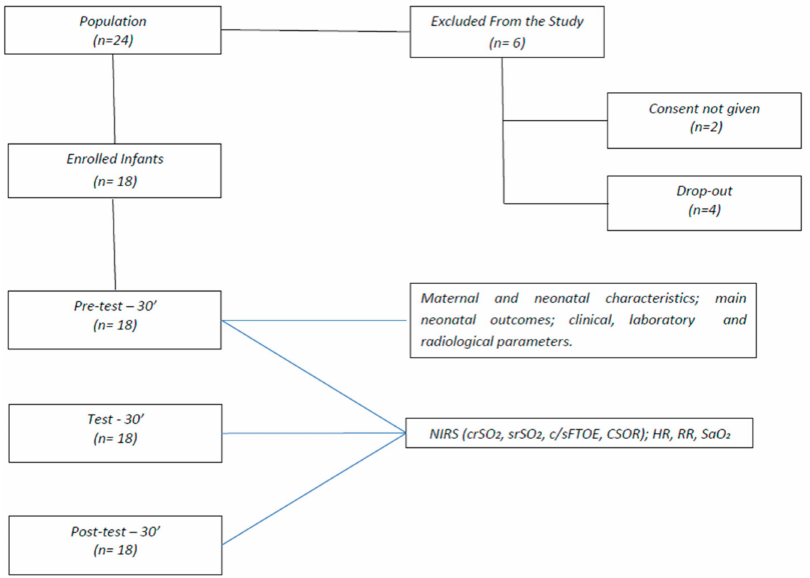
Figure 6. Flowchart of data collection and measurement scenarios. Abbreviations: near infrared spectroscopy, NIRS; regional oxygen saturation, rSO 2 ; cerebral, c; splanchnic, s; fractional tissue oxygen extraction, FTOE; cerebro–splanchnic oxygenation ratio, CSOR; heart rate, HR; respiratory rate, RR; pulsed arterial oxygen saturation, SaO 2